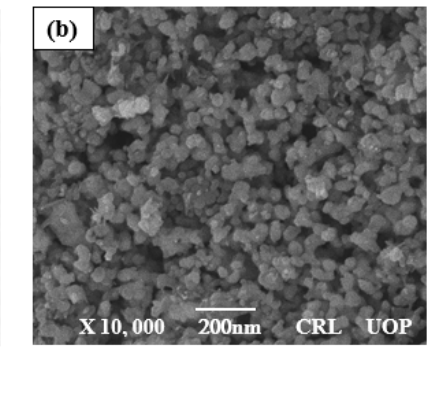
Table 1. XRD parameters of Ni 0.5 Cd 0.5 Ho x Fe 2-x O 4 (x = 0, 0.02, and 0.04) ferrite samples.